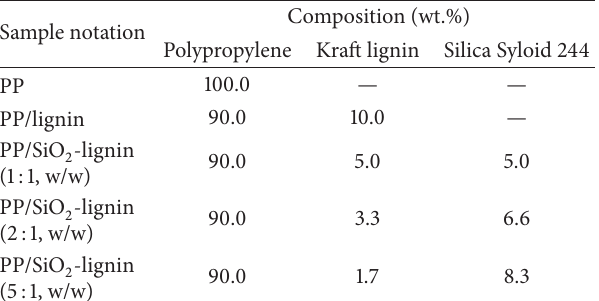
Table 1: Formulations of PP-based composites.